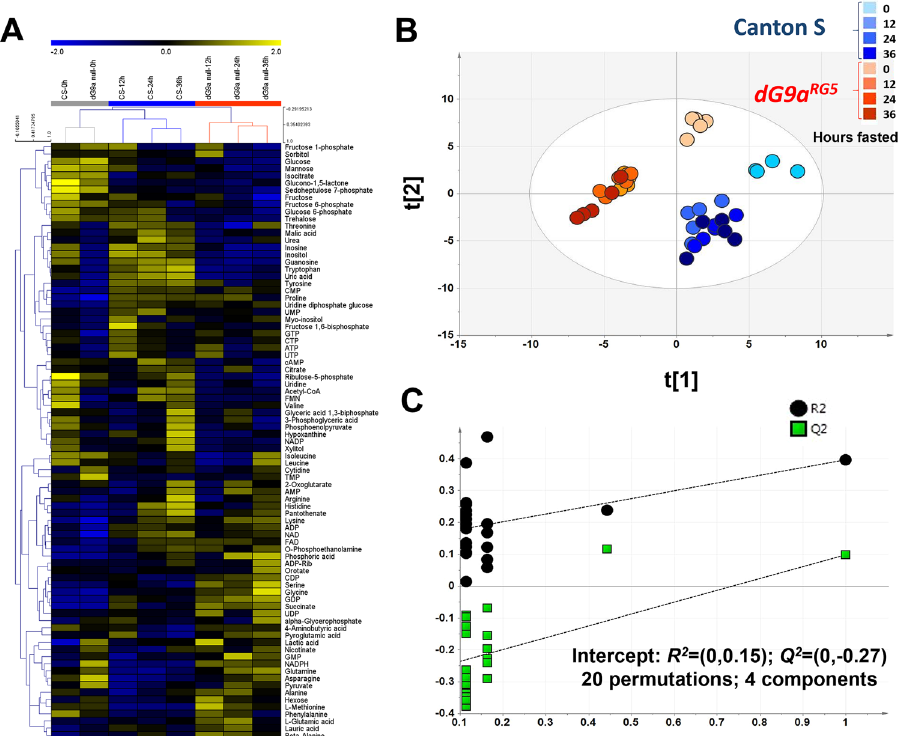
Figure 3. Fasted dG9a RG5 mutant flies show a distinct metabolic profile. ( A ) HCA data showing changes in the cellular metabolites of wild-type and dG9a RG5 mutant flies under starvation; the color scale is plotted on the top of the figure. Before starvation, flies with both genotypes shared similar profiles and were grouped into one cluster (grey). During starvation, flies with each genotype showed different profiles and were discriminated hierarchically into two clusters, wild-type (blue) and dG9a RG5 mutant (red). A similar discrimination based on genotypes was observed on the score plot of the supervised analysis PLS-DA ( B ). In each genotype, samples collected before fasting were clearly separated from samples collected during fasting. ( C ) Statistical validation by the permutation test with 20 permutations of PLS-DA (R 2 Y-intercepts = (0,0.15); Q 2 -interceps = (0, −